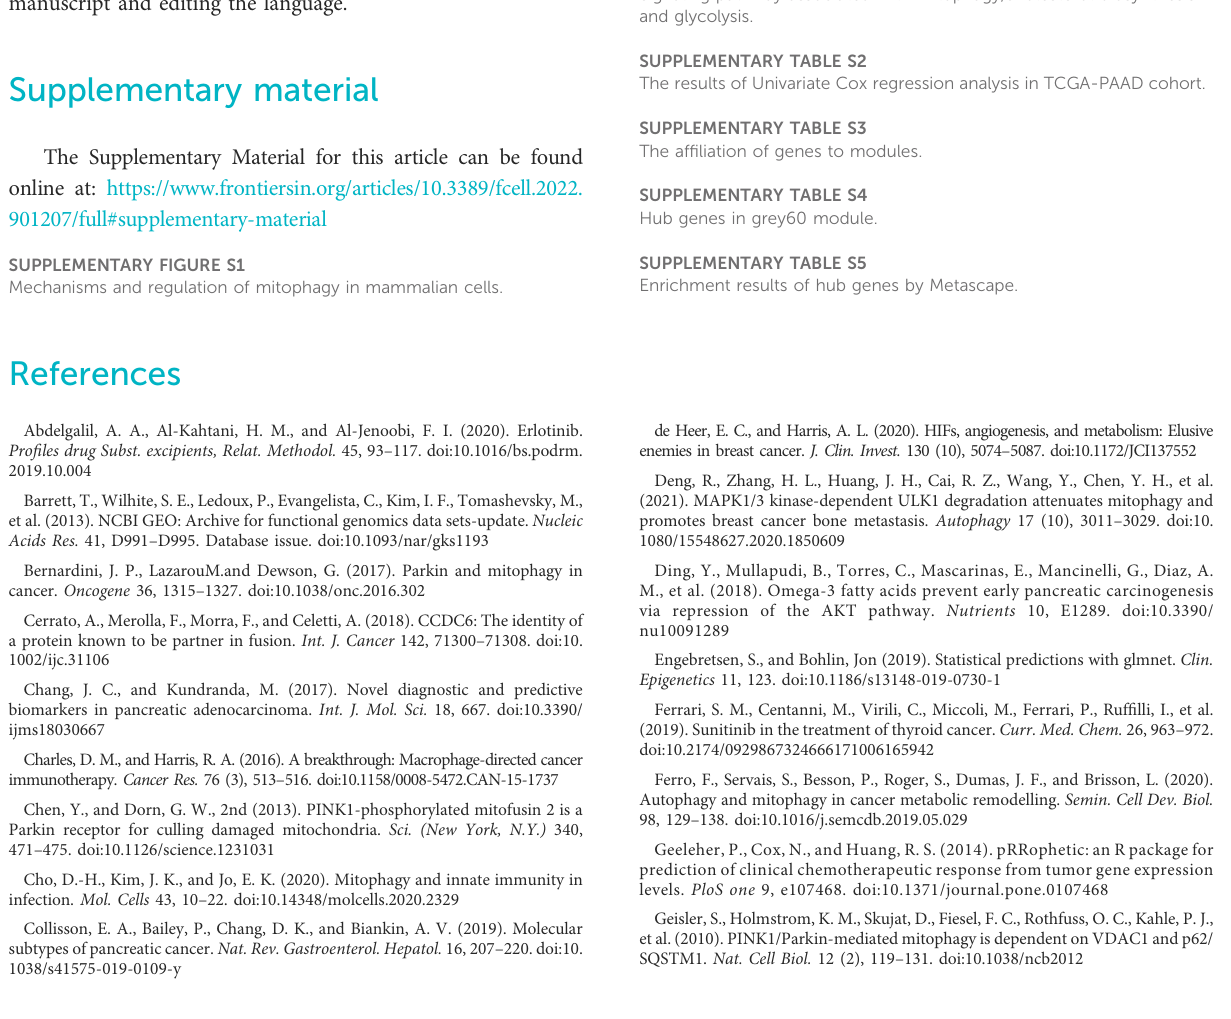
SUPPLEMENTARY TABLE S1 Signaling pathway associated with mitophagy,cholesterol biosynthesis and glycolysis.